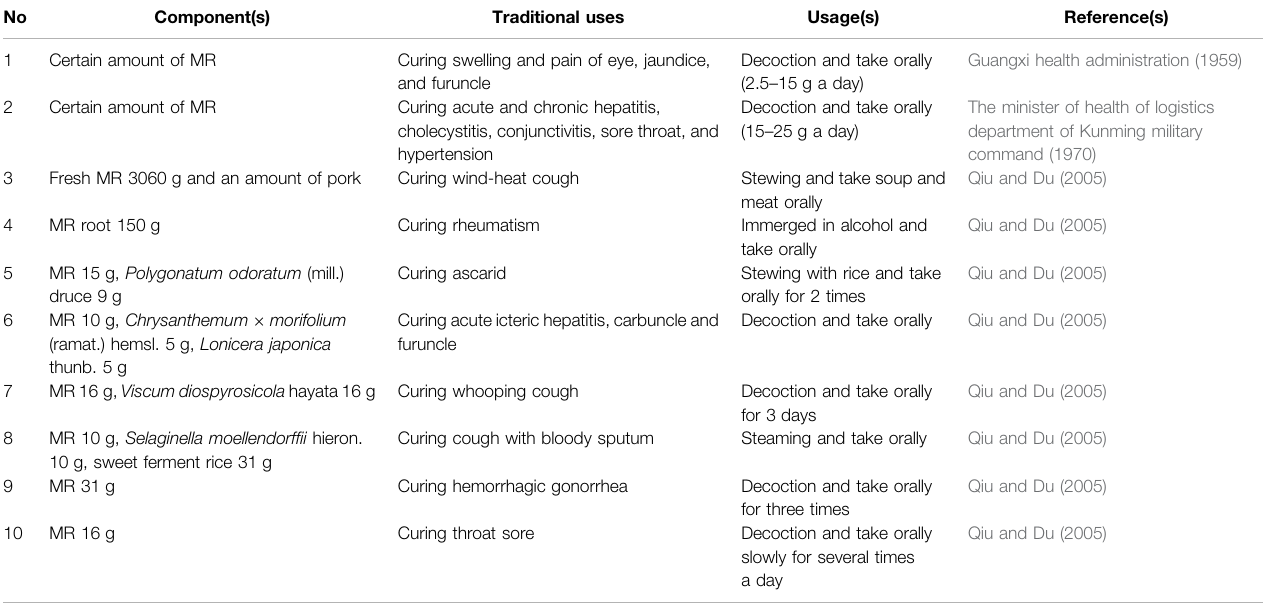
TABLE 1 | Traditional uses of MR in